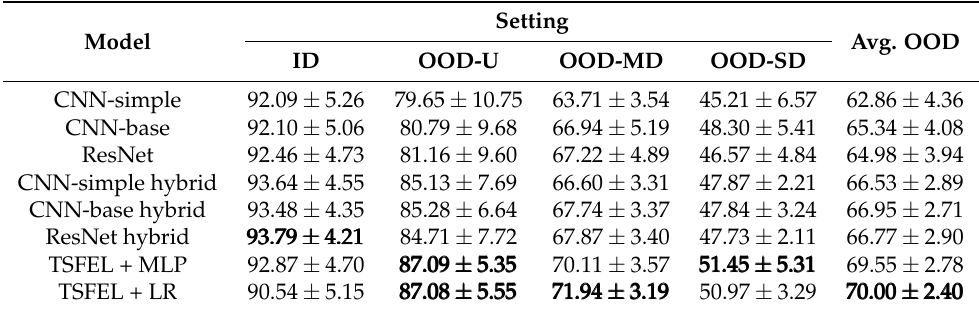
Table 5. Average f1-score in percentage over all the tasks in a given setting. Values in bold indicate the best performance for each